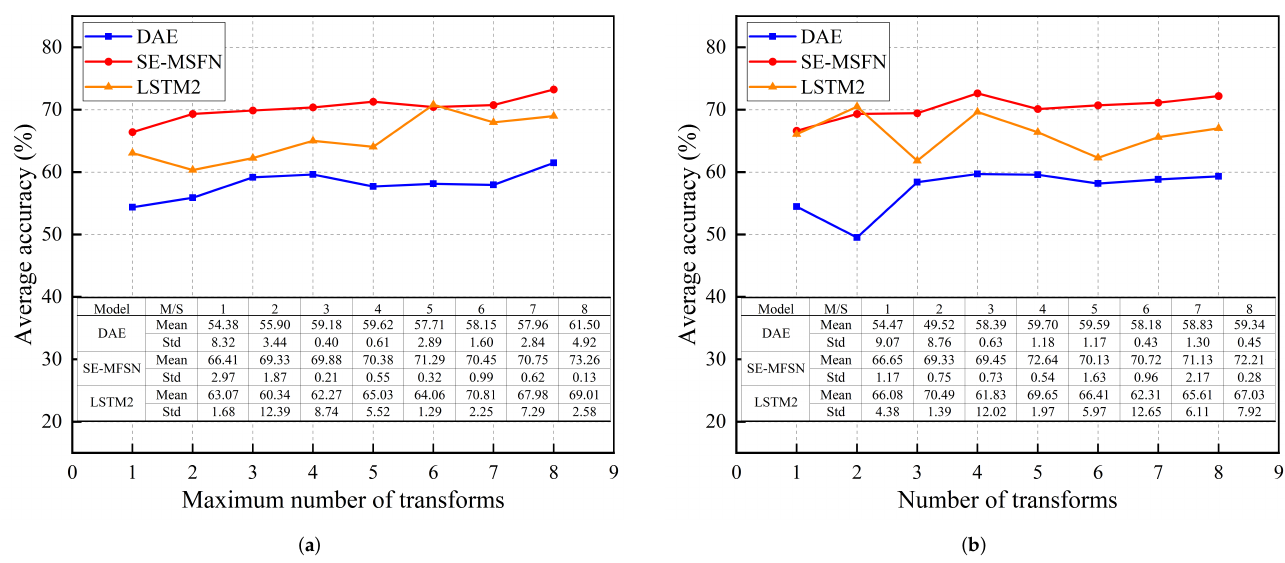
Figure 11. Validation on the 2016A-10b dataset of ( a ) the effect of the maximum number of transfor- mations on SigAugment-R and ( b ) the effect of the number of transformations on SigAugment-C.